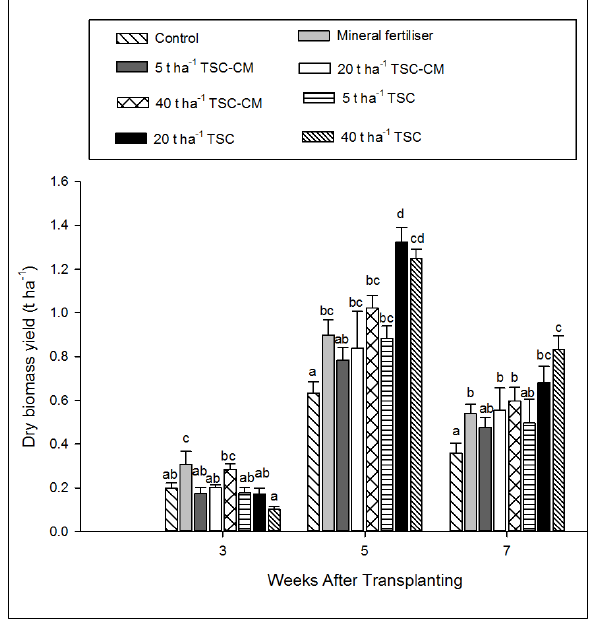
Oilseed rape ( Brassica napus L.) dry biomass yield (mean±s.e.).